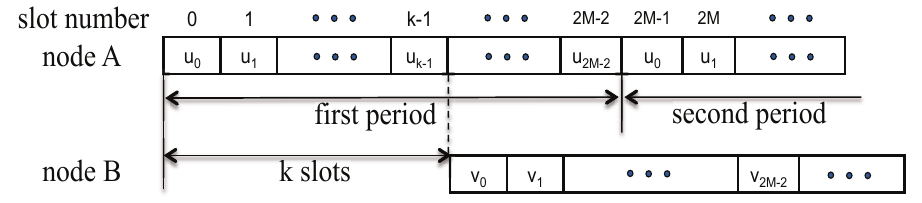
Figure 4. System model